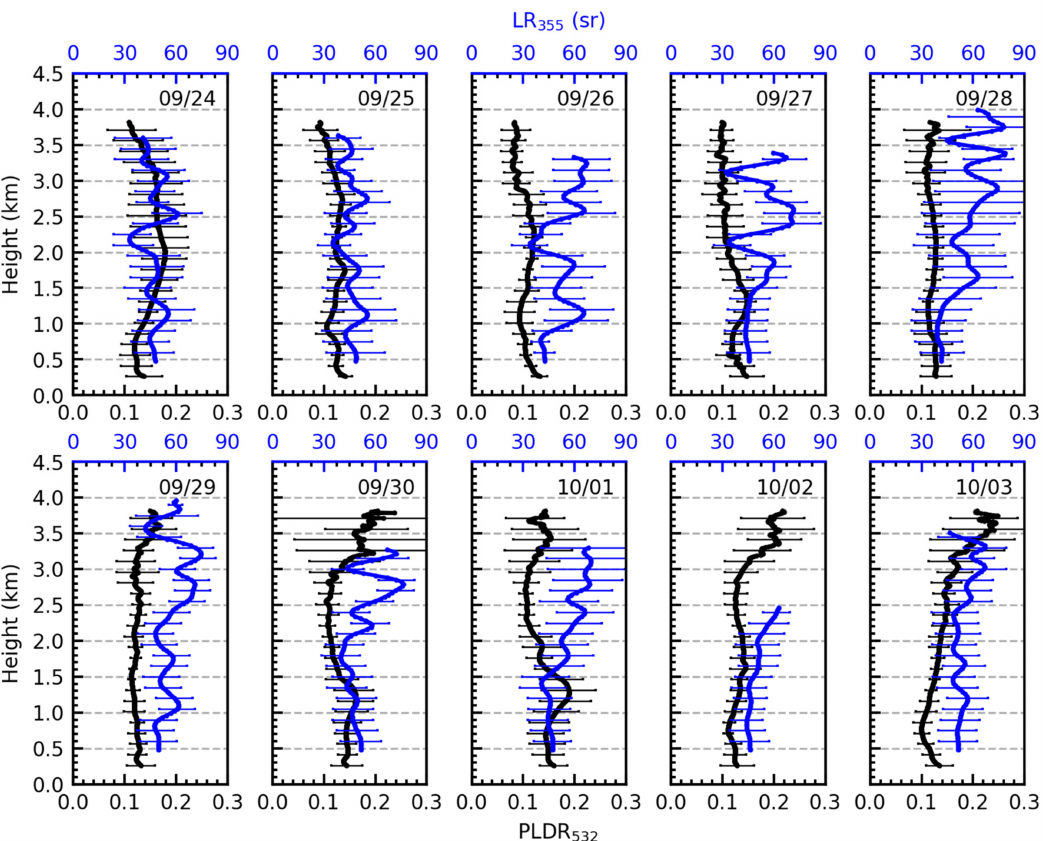
Figure 7. Height profiles of the daily average PLDR 532 ( black ) and night-time average LR 355 ( blue ). The envelopes in PLDR 532 represent the one standard deviation at each height, and the envelopes in LR 355 indicate the errors at each height. The date is displayed at the top right of each panel.